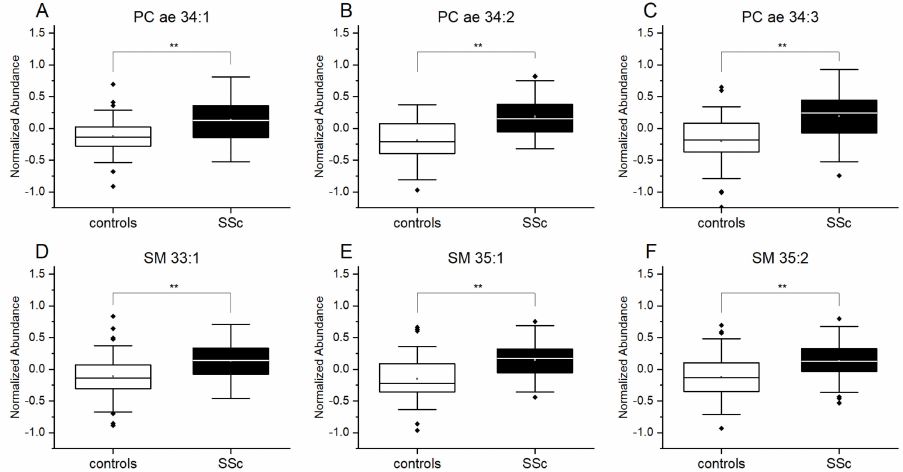
Figure 1. Increased plasma levels of plasmalogens and sphingolipids in patients with SSc. Results of lipidomics measure- ments for ( A ) phosphatidylcholine PC ae 34:1, ( B ) PC ae 34:2, ( C ) PC ae 34:3 and for ( D ) sphingomyelin SM 33:1, ( E ) SM 35:1 and ( F ) SM 35:2. Controls ( n = 48), SSc patients ( n = 52). Data are expressed as normalized abundance. Resulting p -values from group comparisons were determined using a two-tailed Student’s t -test, and p < 0.05 was considered significant (** p <